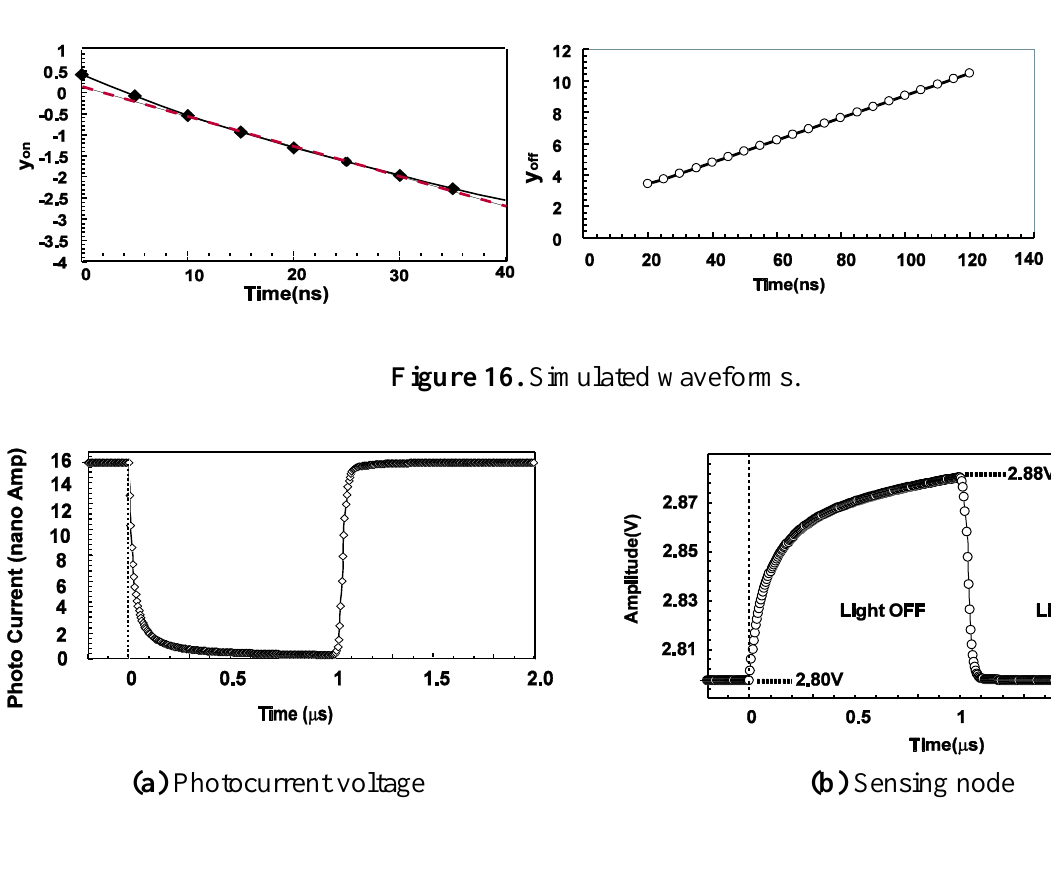
Figure 15. Measured of time constant  from simulation result (a) Light ON phase and (b) Light OFF phase.